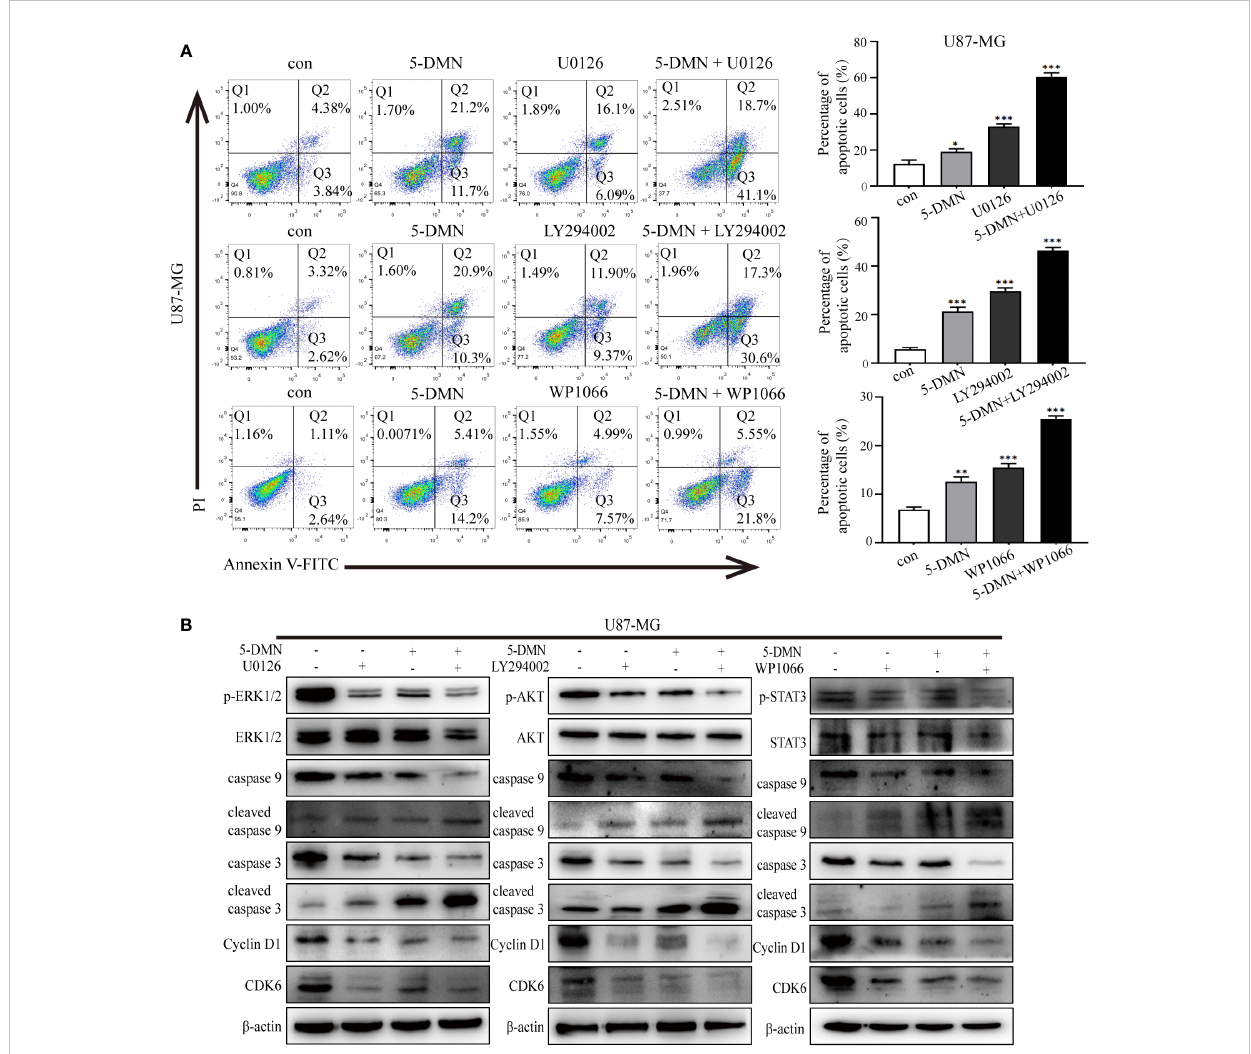
FIGURE 6 The ERK1/2, AKT and STAT3 signaling pathways in fl uence the effects of 5-DMN on cell apoptosis, cycle and apoptosis-related proteins. (A) The apoptotic rate of U87-MG cells was determined using Annexin V-FITC/PI double staining after 5-DMN treatment with or without inhibitor. (B) Western blotting detected cell cycle proteins and apoptosis-related proteins levels in 5-DMN-treated U87-MG cells with or without pathway inhibitors. *p<0.05, **p<0.01, ***p<0.001 vs. cells in the control